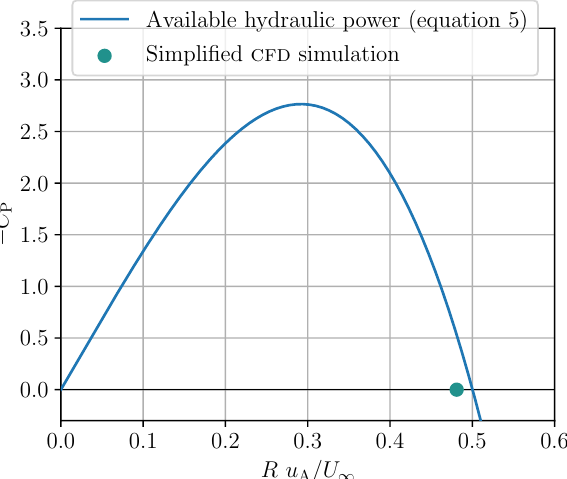
Figure 5. Power coefficient of the WVPP when h 1 = 0.83m & h 2 = 0.7m, as predicted using a single, simplified CFD simulation. The vertical axis is the power coefficient C P based on the frontal area A f (Equation (1)), and the horizontal axis is the adjusted actuator velocity (non-dimensional inlet velocity, directly proportional to the mass flow). The large dot on the zero- y axis stands for the value read out from the simplified CFD simulation, while the power curve is the solution to Equation (5), calibrated with the K D2 value obtained from the